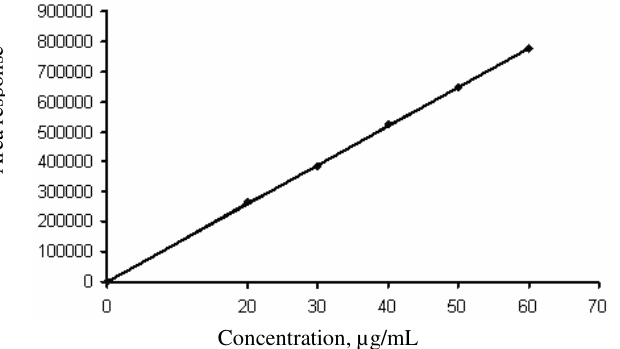
Figure 3. Calibration plot for aripiprazole.